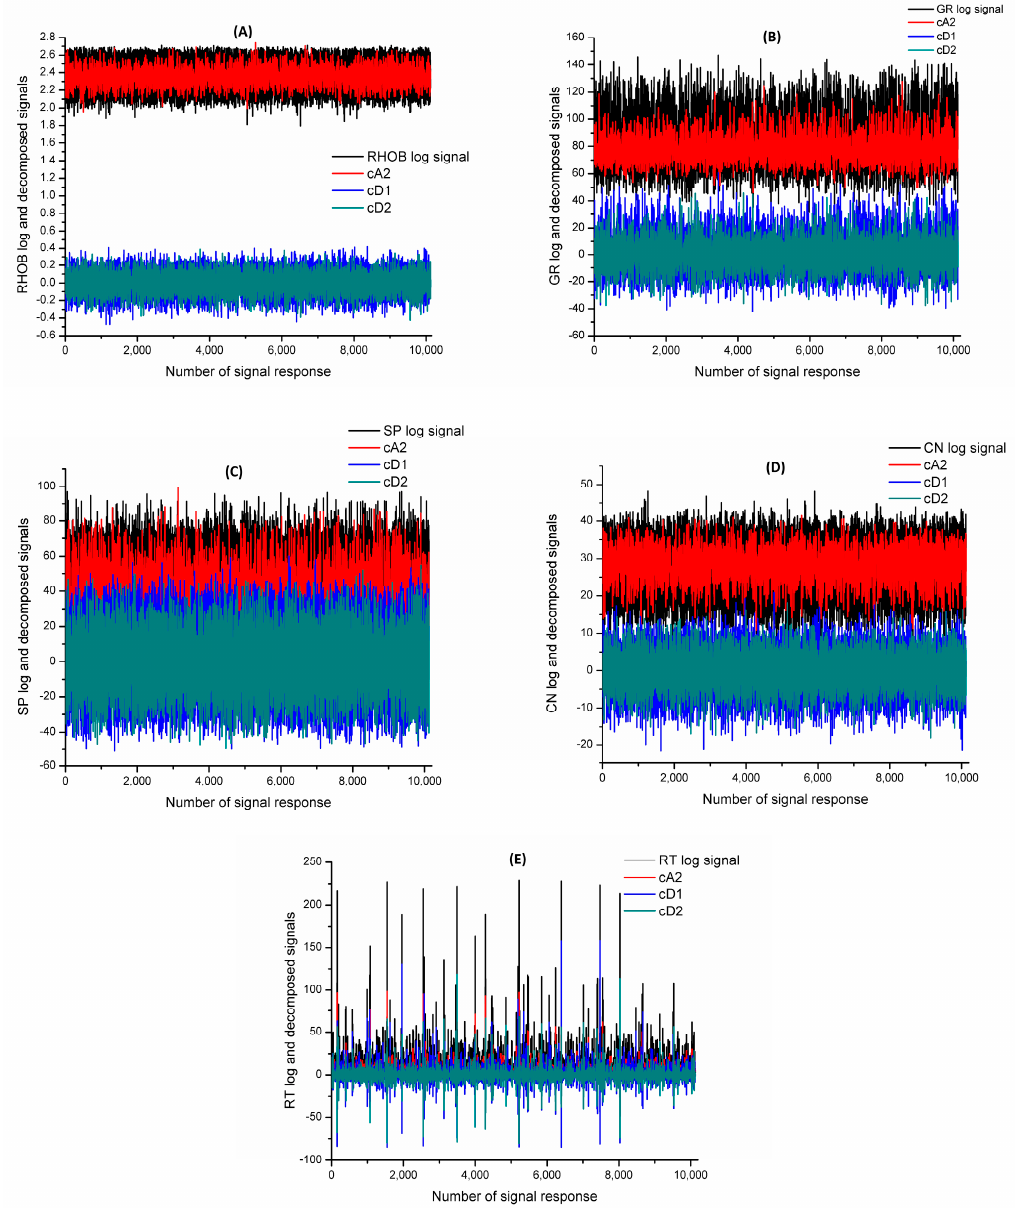
Figure 6. Decomposed wavelet signals for ( A ) RHOB; ( B ) GR; ( C ) SP; ( D ) CN; and ( E ) RT well log using the db-2 and sym-2 wavelet functions.